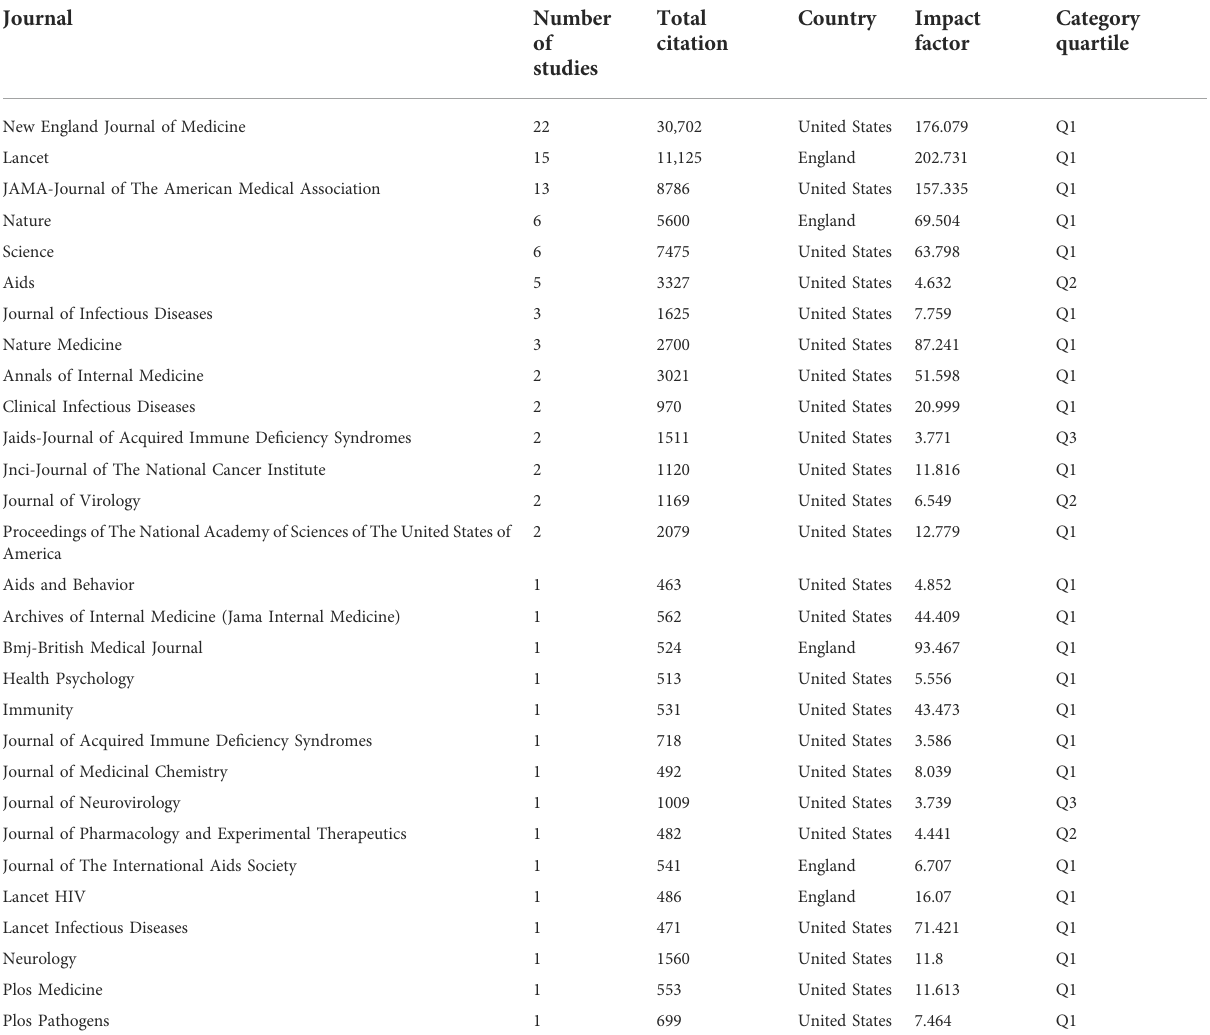
TABLE 5 Journal distribution of 100 top cited studies in drug therapy for HIV fi